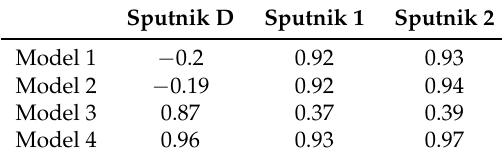
Table 1. Coefficients of determination ( R 2 ) for models (1)–(4).